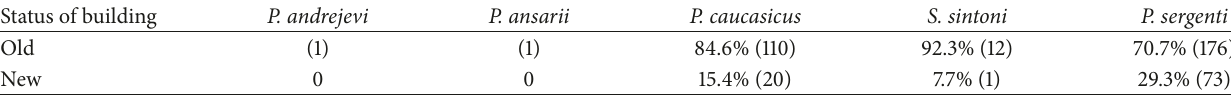
Table 2: The effect of buildings status on density of sand flies captured in Yazd city, 2015.